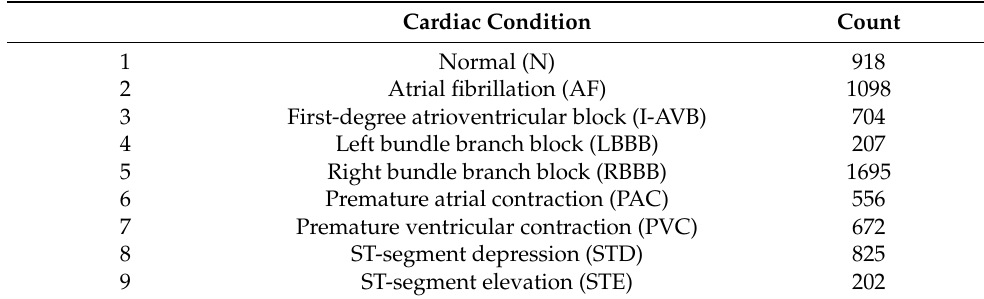
Table 1. ECG Data Included in the CPSC2018